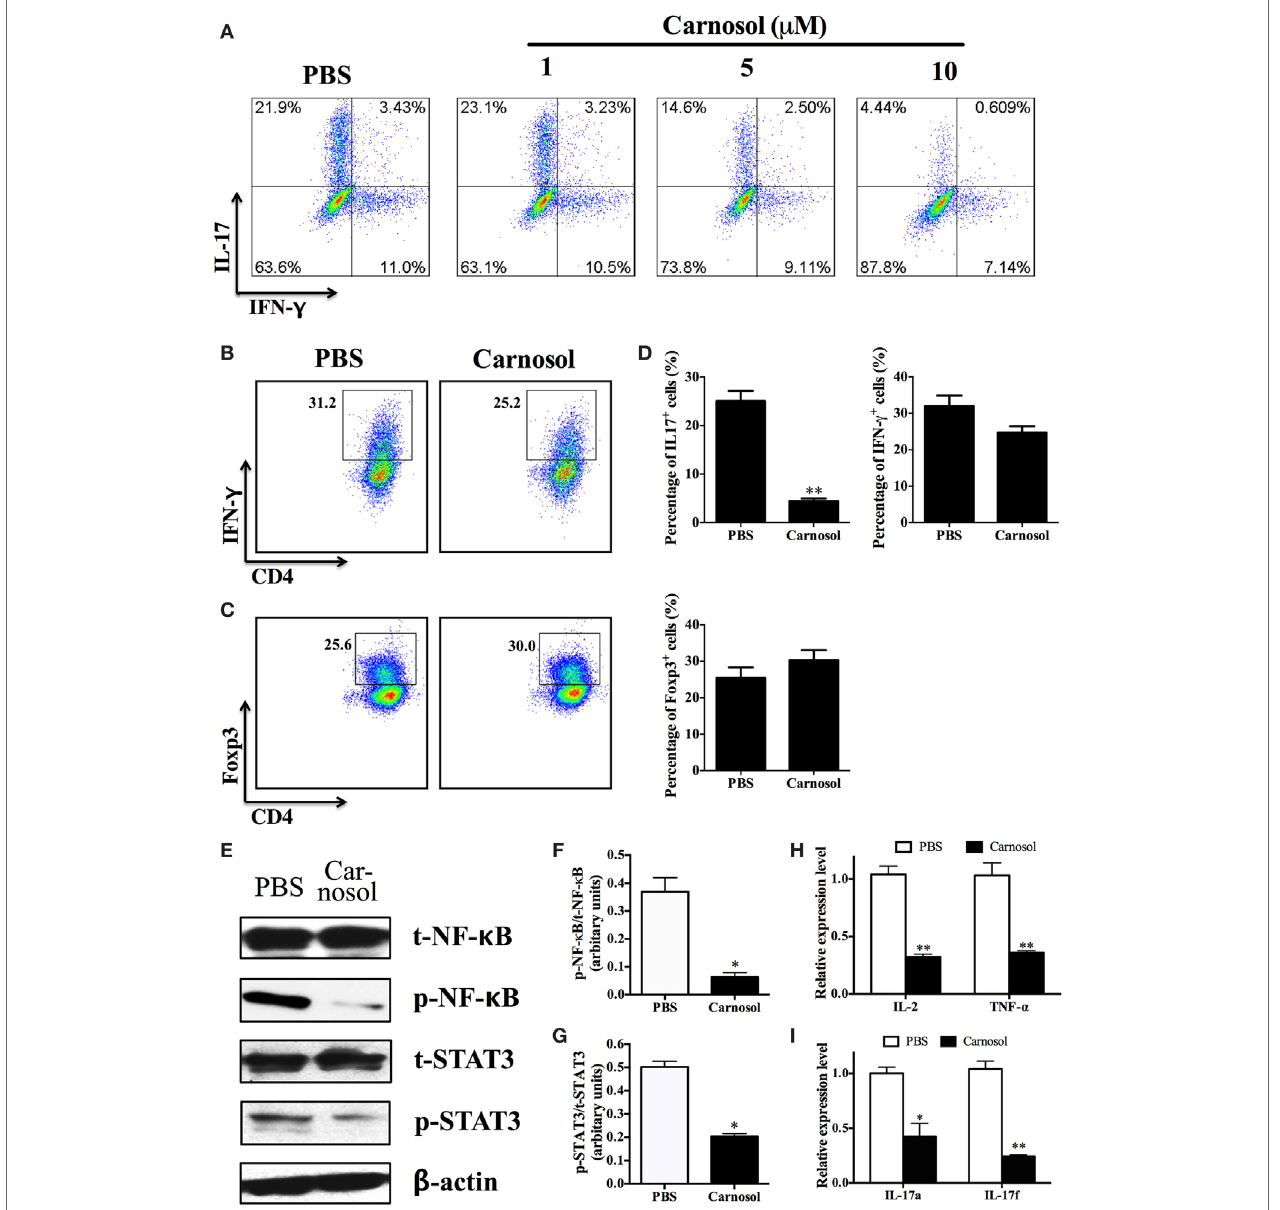
FigUre 4 | Carnosol suppressed Th17 cell differentiation by blocking the function of NF- κ B and signal transducer and activator of transcription 3 (STAT3). (a) CD4 + cells were isolated from C57Bl/6 mice and cultured under the Th17 polarizing condition with different concentrations of carnosol for 3 days. Percentage of Th17 cells was analyzed by intracellular staining of IL-17. (B,c) CD4 + cells were cultured under the Th1 and regulatory T cell (Treg) polarizing condition with carnosol (10 µM) for 3 days. Percentages of Th1 and Treg cells were analyzed by intracellular staining of IFN- γ + and Foxp3 + , respectively. (D) Statistical analysis of (a–c) . (e) CD4 + T cells were cultured under Th17 polarizing condition and treated with 10 µM carnosol or PBS for 3 days. Cells were then analyzed for NF- κ B and STAT3 expression by Western blot. (F,g) Statistical analysis of (e) . (h,i) Cells were harvested as described in (e) and subjected to RNA extraction and cDNA production. Expression of pro-inflammation cytokines and IL-17 members (IL-17a and IL-17f) was determined by real-time PCR. Symbols represent mean ± SD ( n = 3 each group). * p < 0.05 and ** p < 0.01. Student’s t -test. One representative of three independent experiments is